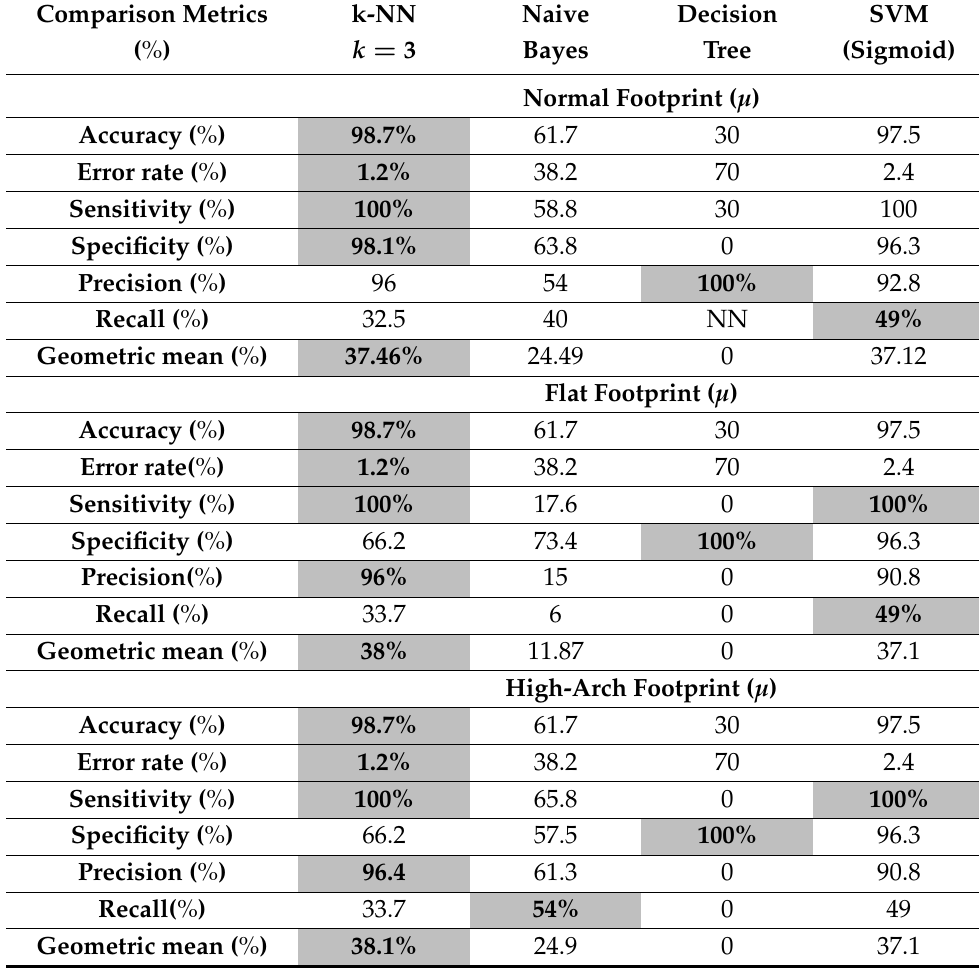
Table 3. Matrix X classification metrics’ comparison under Stage